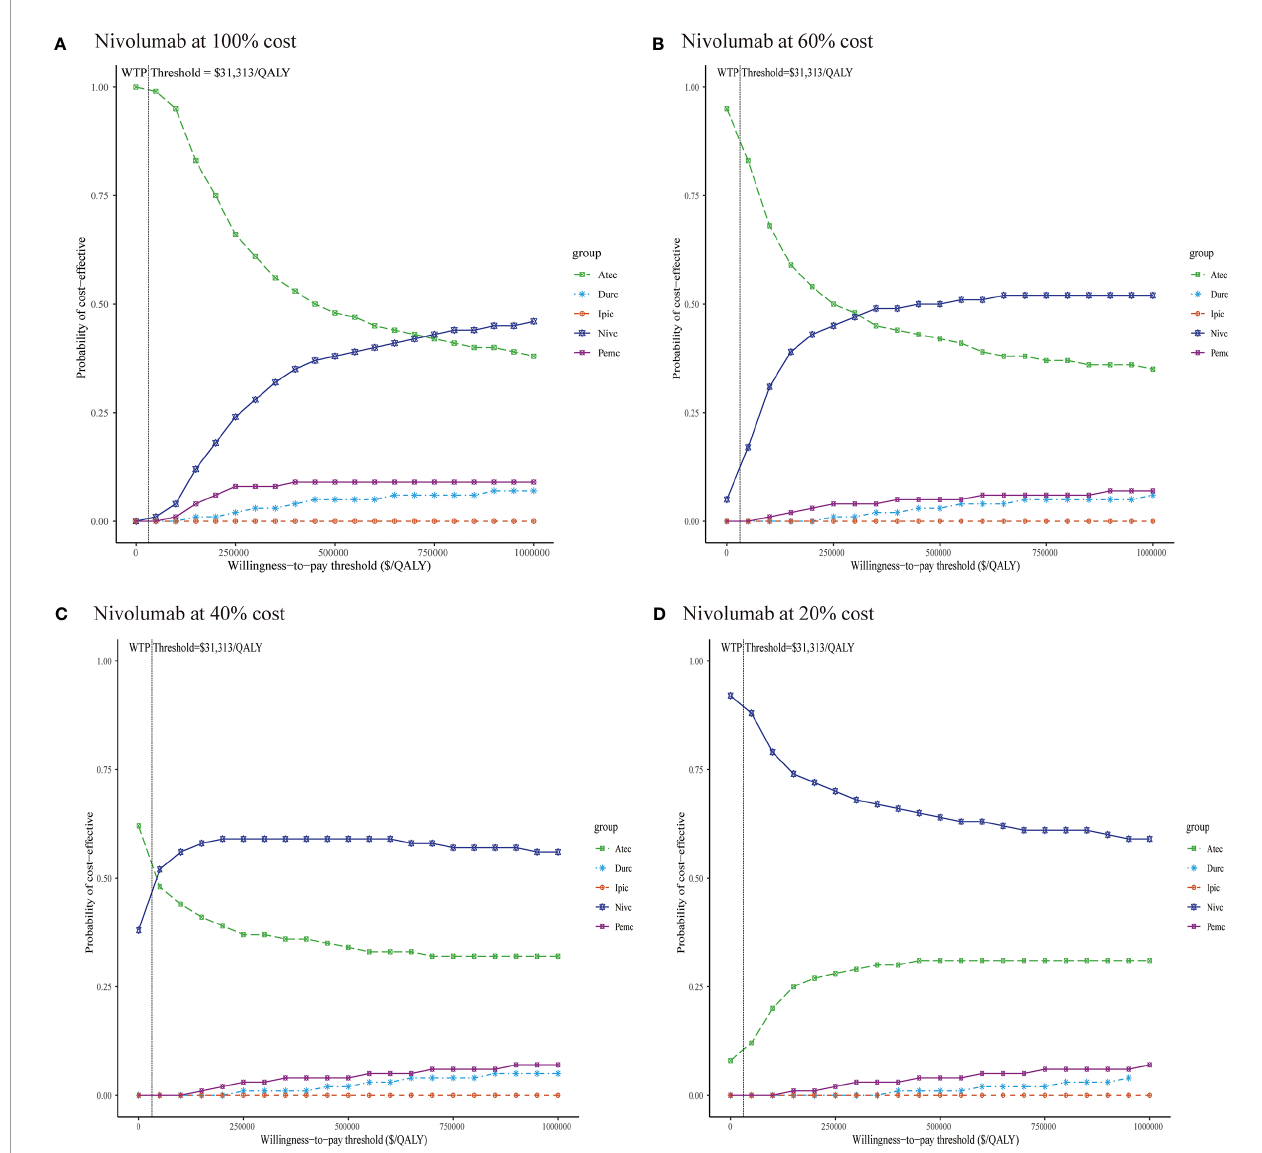
FIGURE 3 | Cost-effectiveness acceptability curves of fi ve immunotherapy plus chemotherapy regimens (A) Nivolumab at 100% cost, (B) Nivolumab at 60% cost, (C) Nivolumab at 40% cost, (D) Nivolumab at 20% cost. Durc, durvalumab plus chemotherapy; Atec, atezolizumab plus chemotherapy; Pemc, pembrolizumab plus chemotherapy; Nivc, nivolumab plus chemotherapy; Ipic, ipilimumab plus chemotherapy; QALY, quality-adjusted life year; WTP,